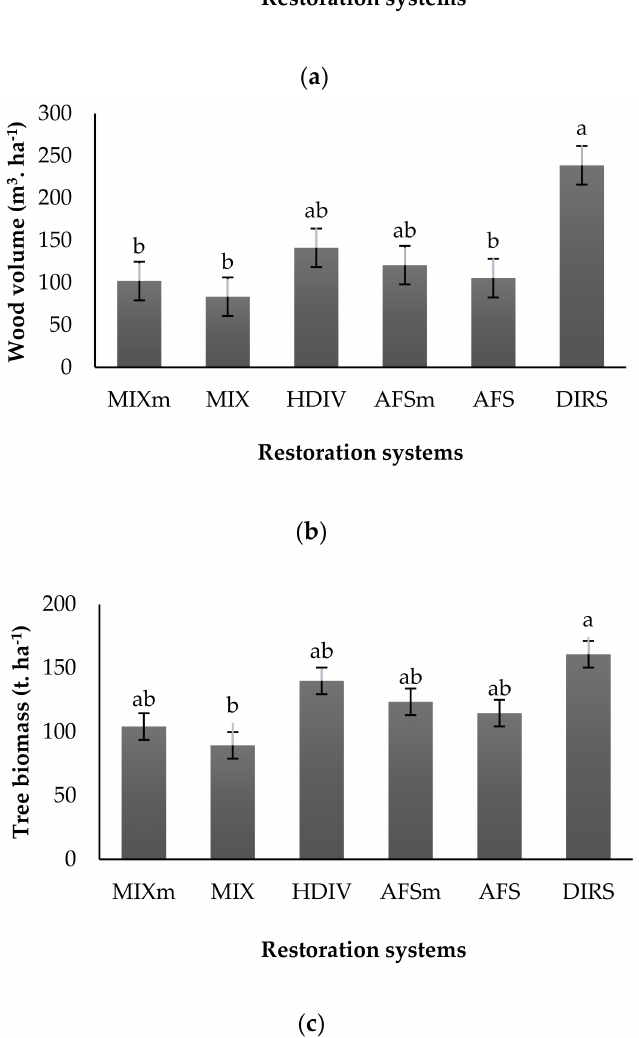
Figure 4. Stand basal area ( a ), wood volume ( b ), tree biomass ( c ) in di ff erent ecological restoration systems of the tropical semideciduous seasonal forest in Botucatu, S ã o Paulo, at 19–20 years after planting. Labels: MIXm (‘managed’ commercial mixed plantation), MIX (commercial mixed plantation), HDIV (high-diversity tree plantation), AFSm (‘managed’ agroforestry system), AFS (agroforestry system), DIRS (direct seeding). Bars represent average and standard error. Results for pooled sites data. Treatment means labelled with the same letters are not statistically di ff erent at 5% probability level (Tukey’s